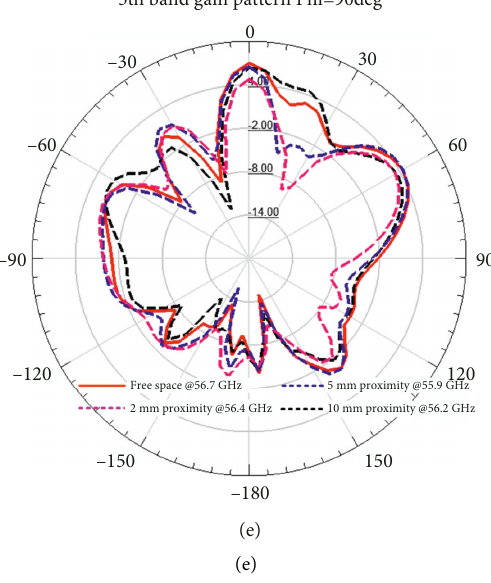
Figure 14: H-plane pattern of optimized antenna at various distances from human body model. Table 5: Performance comparison of this work with similar works in the